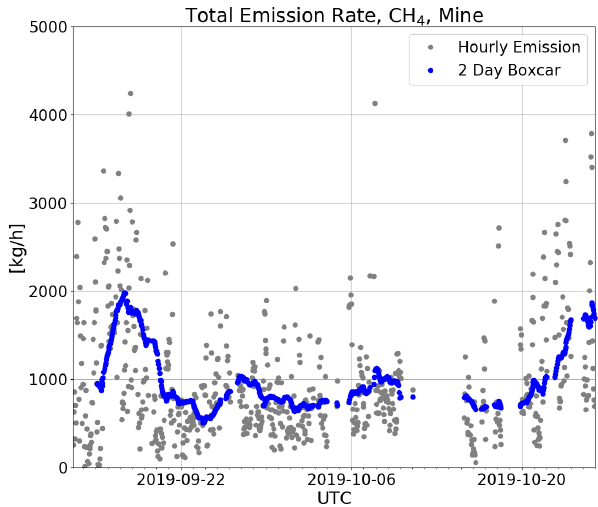
Figure 9. Open-pit mine methane